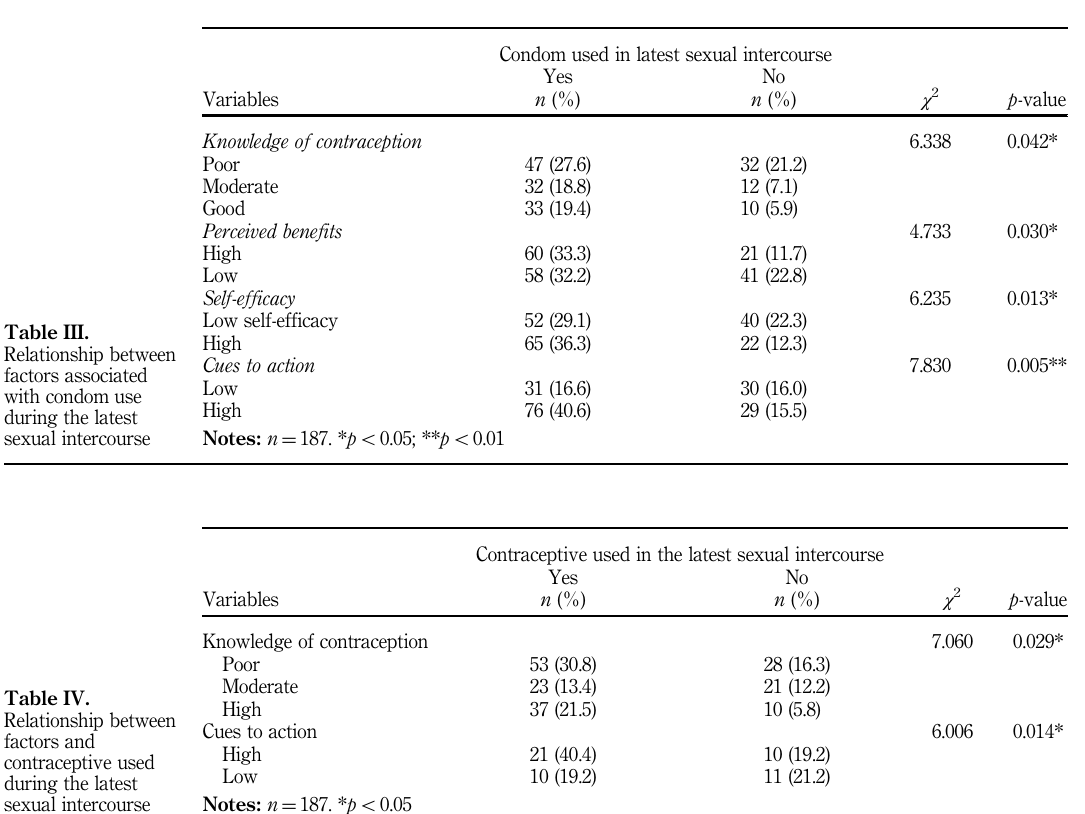
Variables n (%) n (%) χ 2 Knowledge of contraception Table IV. Relationship between factors and contraceptive used during the latest sexual